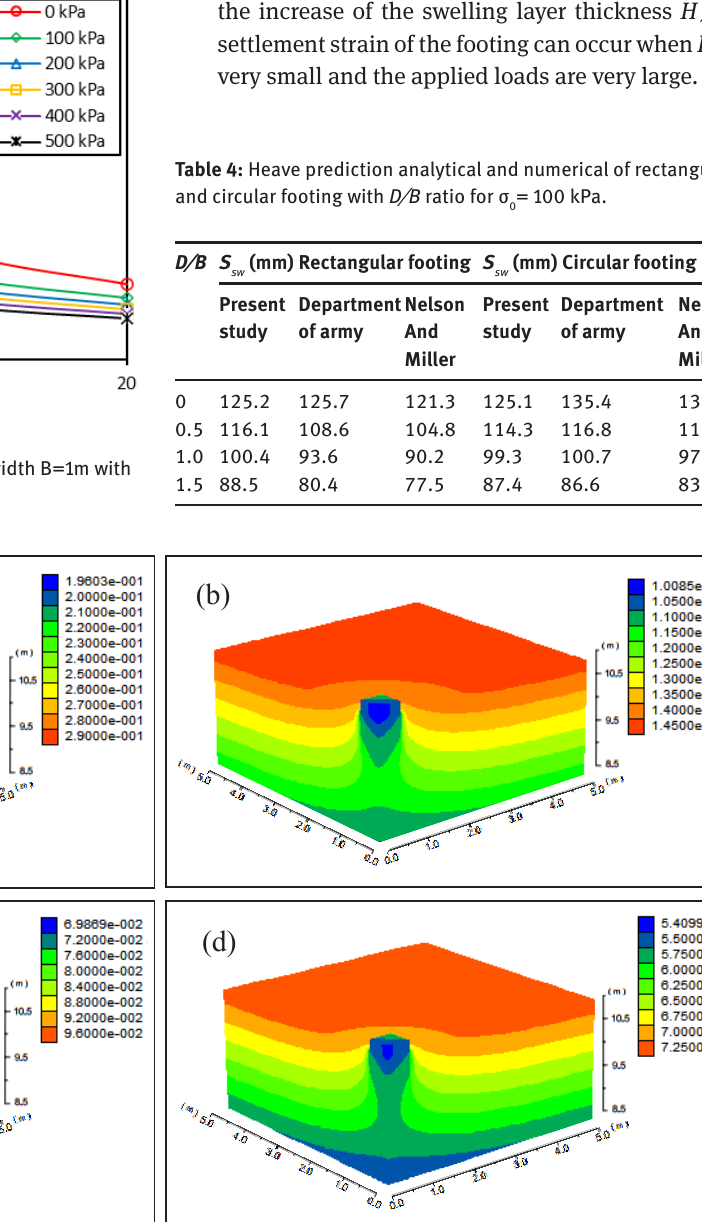
Figure 14: Contours heaving of square footing of width B=1m and σ MPa, (d) E =20 soil